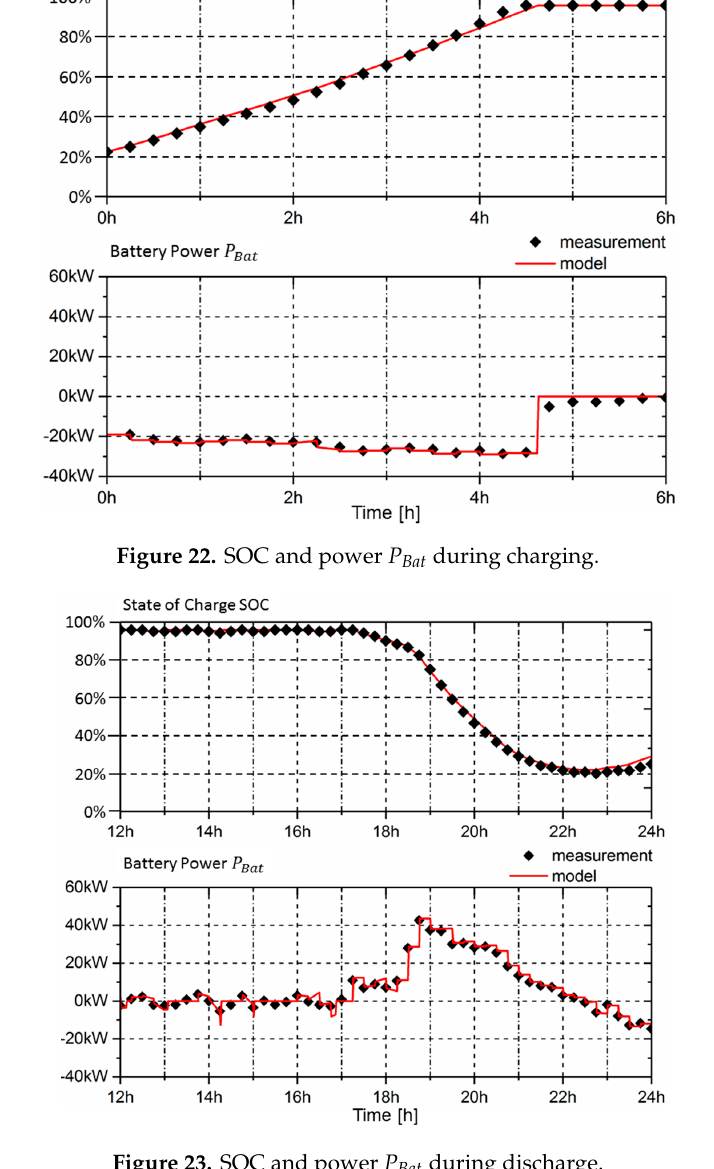
Figure 23 . SOC and power 𝑃 (cid:3003)(cid:3028)(cid:3047) during discharge .